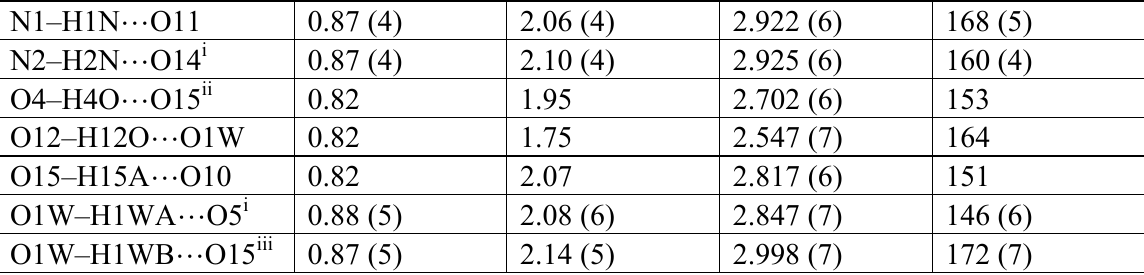
Table 2. Hydrogen bonds in 1